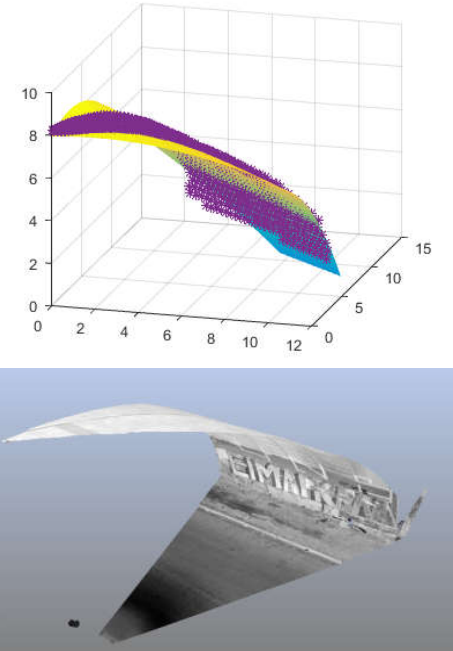
Figure 10: Tested methodology for deformation estimation. Above : the measured data are presented with the purple